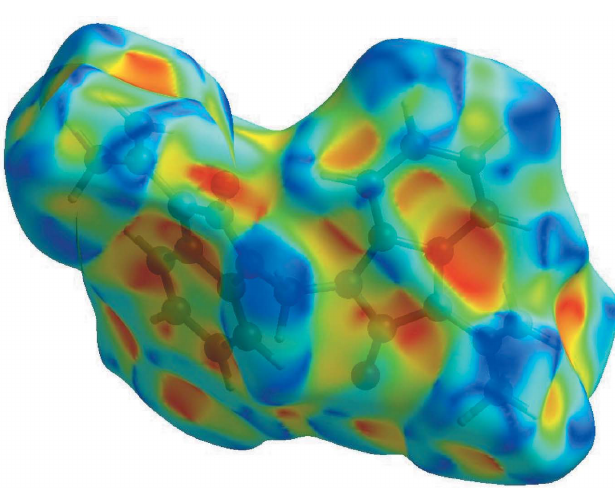
Figure 5 Hirshfeld surface of the title compound plotted over shape-index.